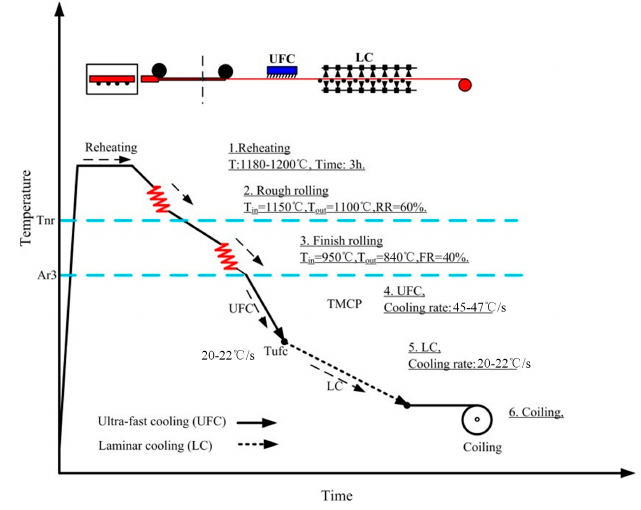
Figure 1. Schematic diagram of thermomechanical-controlled processing (TMCP) for the studied steel. Microstructural characterization was performed by using a ZEISS ULTRA-55 field-emission scanning electron microscope (SEM) equipped with an electron backscattered di ff ractometer (EBSD) and a Tecnai G 2 F20 transmission electron microscope (TEM). The element distributions were examined by EPMA. The SEM specimens were polished mechanically by using a standard metallography procedure and etched with 4% nital for 20 s. The EBSD specimens were polished mechanically and then electropolished (current 0.8 A, time 30 s) using an electrolyte that consisted of perchloric acid and alcohol (1:7 v / v ). EBSD and TEM samples were taken from the center of the steel strip. The angle ◦ between the longitudinal axis of the impact specimen and the rolling direction was 30 . Round bar tensile specimens of 60 mm (gauge length) × 8 mm (diameter) were machined with a longitudinal axis parallel to the rolling direction. The tensile test was performed by using a universal testing machine (crosshead speed 2 mm / min). Standard Charpy–V type impact specimens (10 mm × 10 mm × 55 mm) ◦ ◦ were used for the impact experiment from 0 C to − 120 C. Tensile and impact specimens were taken from the center of the steel strip. DWTT samples (305 mm × 76.2 mm × 22 mm) were machined according to SY / T 6476 Chinese